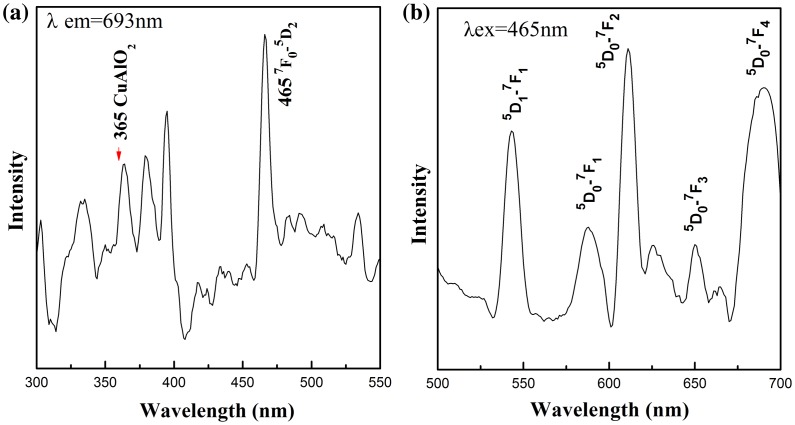
Photoluminescence excitation spectrum (a) showing the direct band-gap transition in CuAlO2 host, and the emission spectrum (b) of CuAl0.99Eu0.01O2.